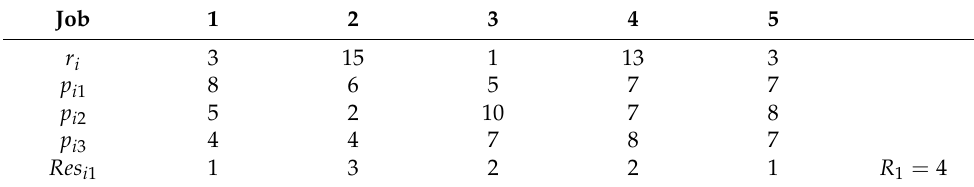
Table 1. Example input parameters.